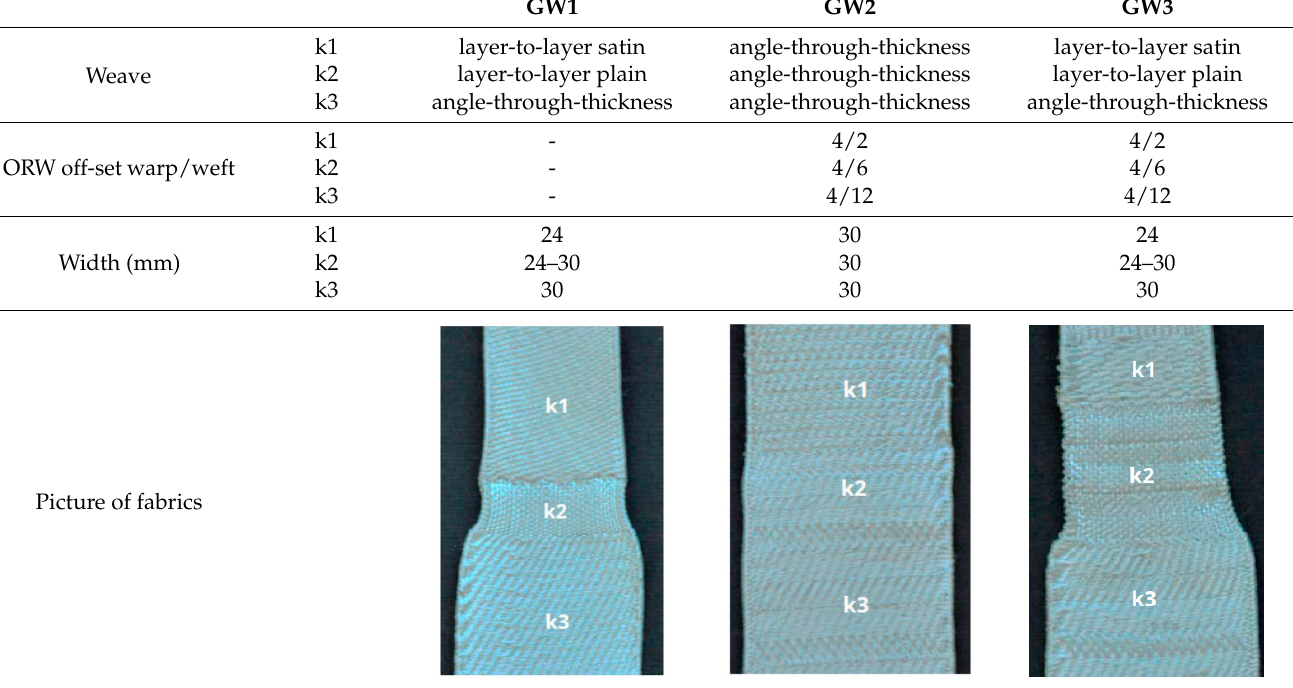
Table 3. Developed woven structures with geometrical and/or structure mechanical gradient.